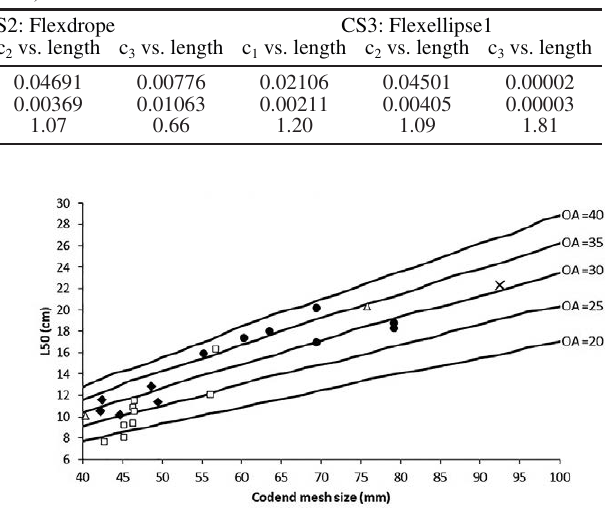
, c and c is in mm. Formulae for cross-section models 1 2 3